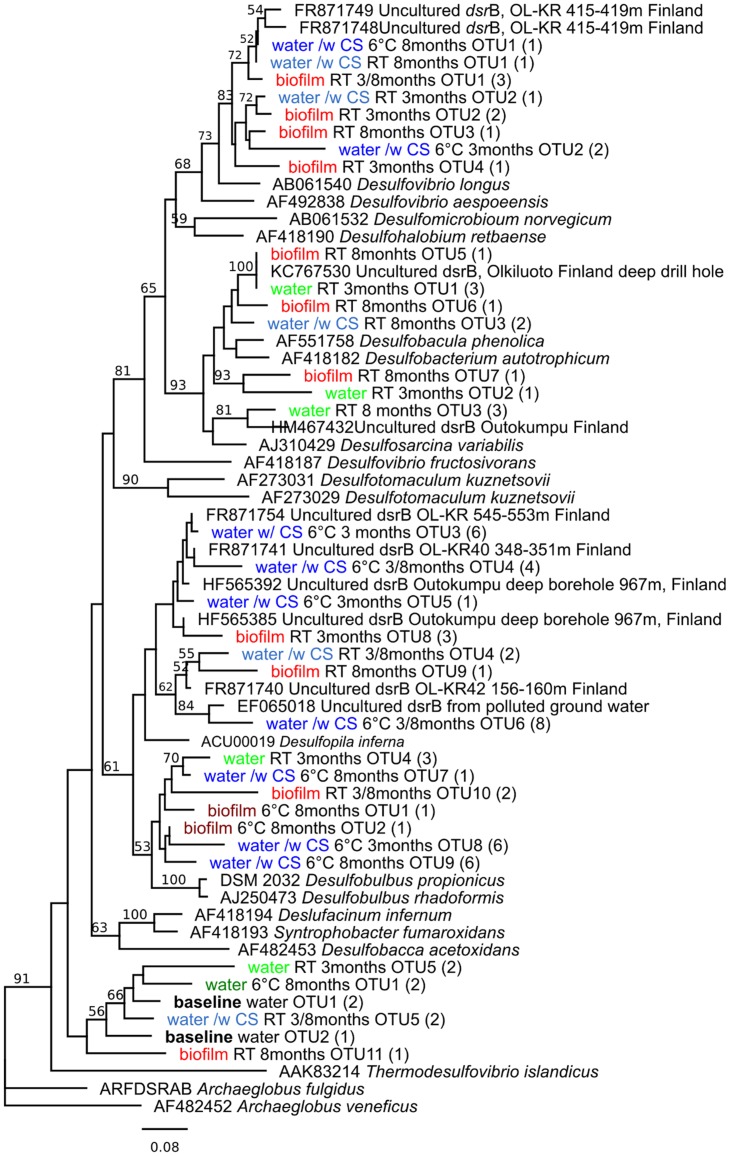
Phylogenetic tree of sulfate reducing bacteria, based on the dsrB sequences (amino acid) obtained by dsrB gene-based PCR-DGGE, in relation to cultured SRB and the closest uncultured relatives. Parentheses indicate the number of individual sequences within the OTU. Bootstrap values, calculated from 1,000 repetitions, are shown at branch points with >50% support. The scale bar indicates 0.08 amino acid substitutions. The tree is rooted by Archaeoglobus veneficus.